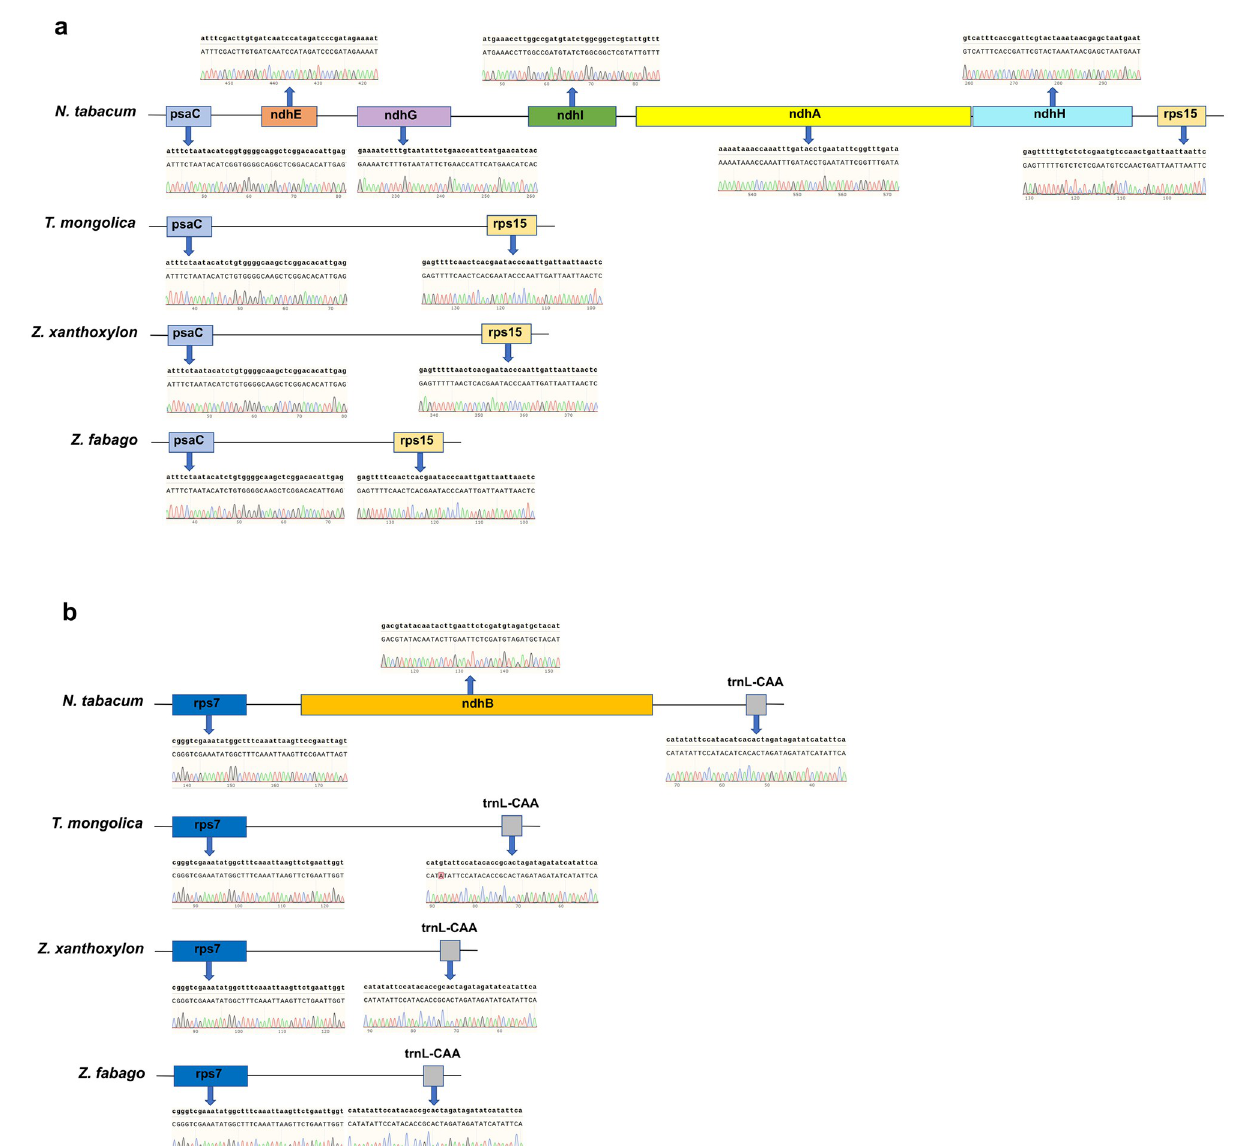
Fig 2. Comparison of sequencing results of PCR products among chloroplast genomes of tobacco, T . mongolica , Z . xanthoxylon , and Z . fabago to show the loss of ndh genes. Tobacco chloroplast genome as the reference. (a) Comparison of the fragment psaC - ndhE - ndhG - ndhI - ndhA - ndhH - rps15 in tobacco and corresponding regions in the chloroplast genomes of T . mongolica , Z . xanthoxylon , and Z . fabago . (b) Comparison of the fragment rps7 - ndhB - trnL-CAA in tobacco and corresponding regions in chloroplast genomes of T . mongolica , Z . xanthoxylon , and Z . fabago . The screenshots indicated by the blue arrows were excerpts from the PCR sequencing results of each gene. Z . xanthoxylon , and Z . fabago (Fig 3). A total of 53, 40, and 38 long repeats were detected in